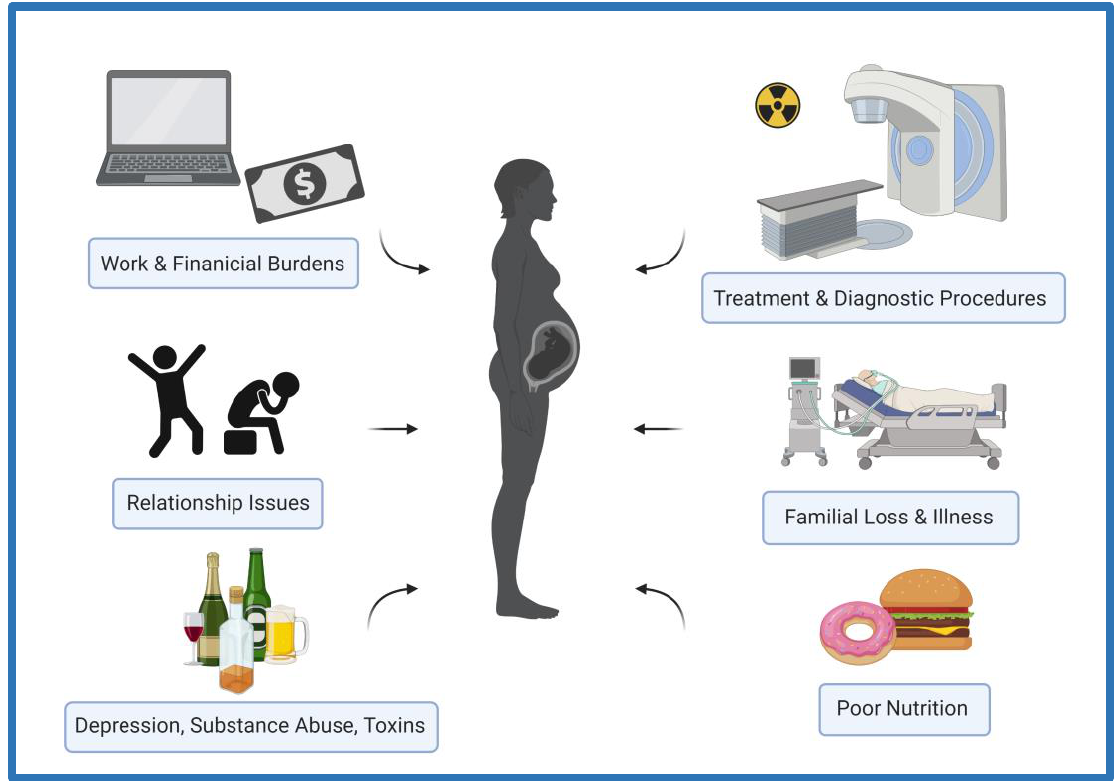
Figure 1. Various maternal stressors. Created with BioRender.com.